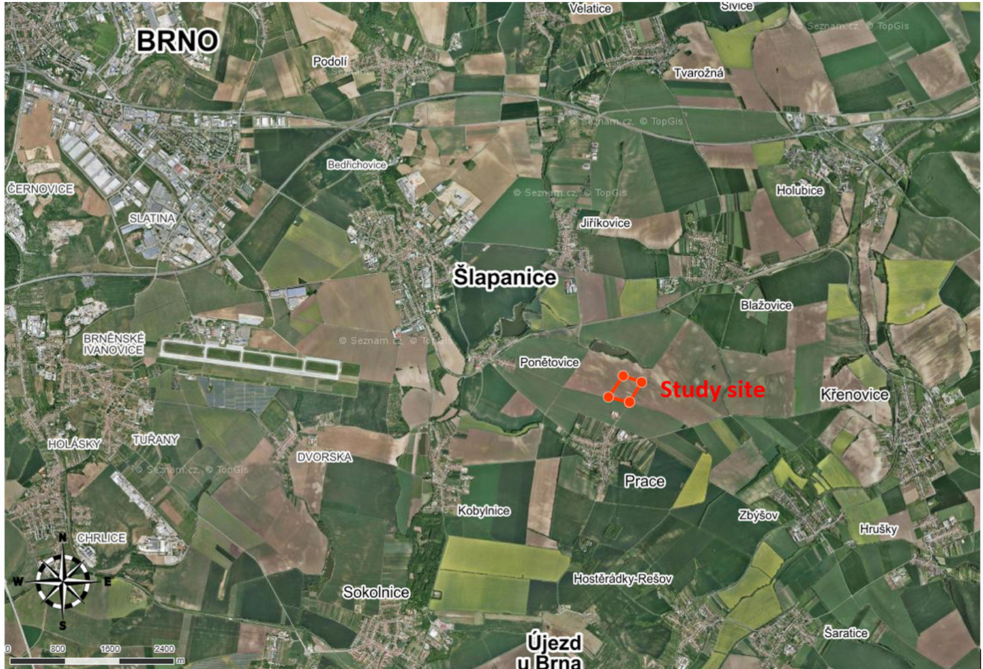
Figure 2. The location of the fields observed in the